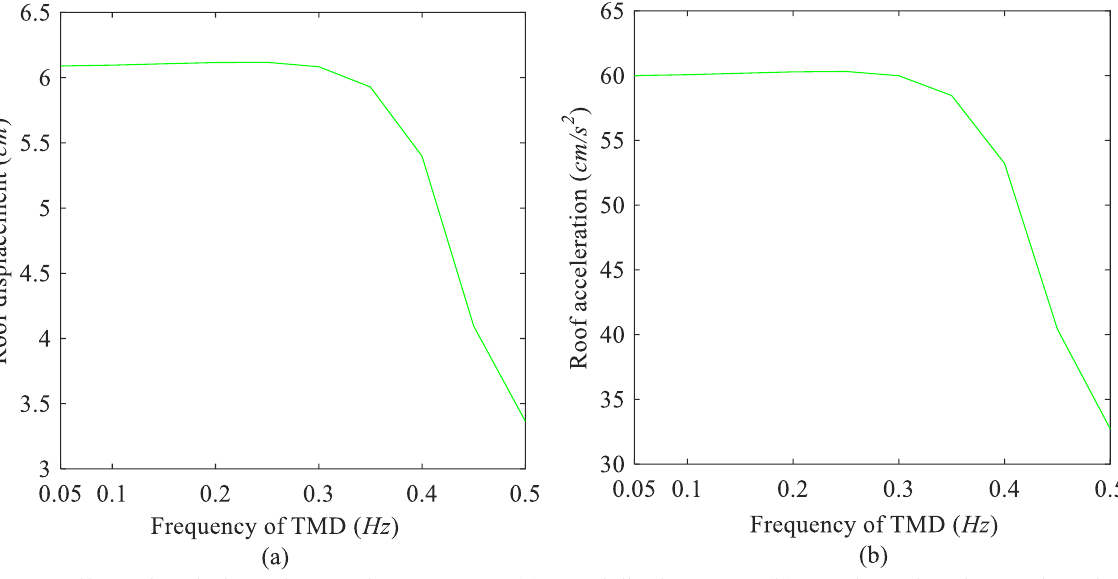
Fig. 17. Effect of variation of TMD frequency on (a) Roof displacement (b) Roof acceleration under wind